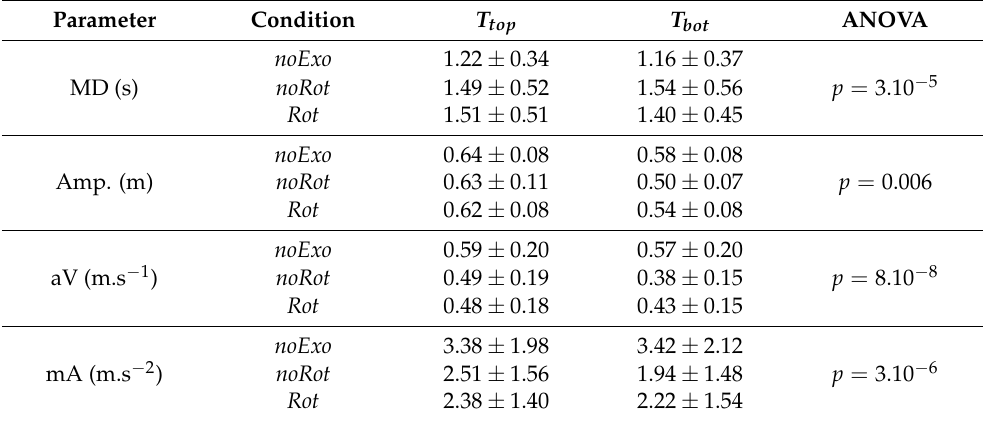
Table 1. Summary of the computed descriptors of the kinematics for each condition. The ANOVA significance level associated with each parameter is given in the last column.